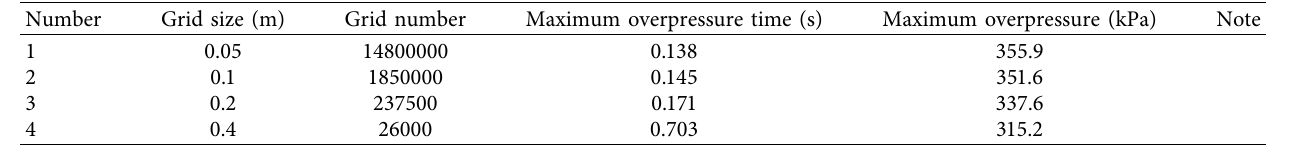
Figure 4: Relationship between solution error and grid size. Table 1: Simulation results of different grid